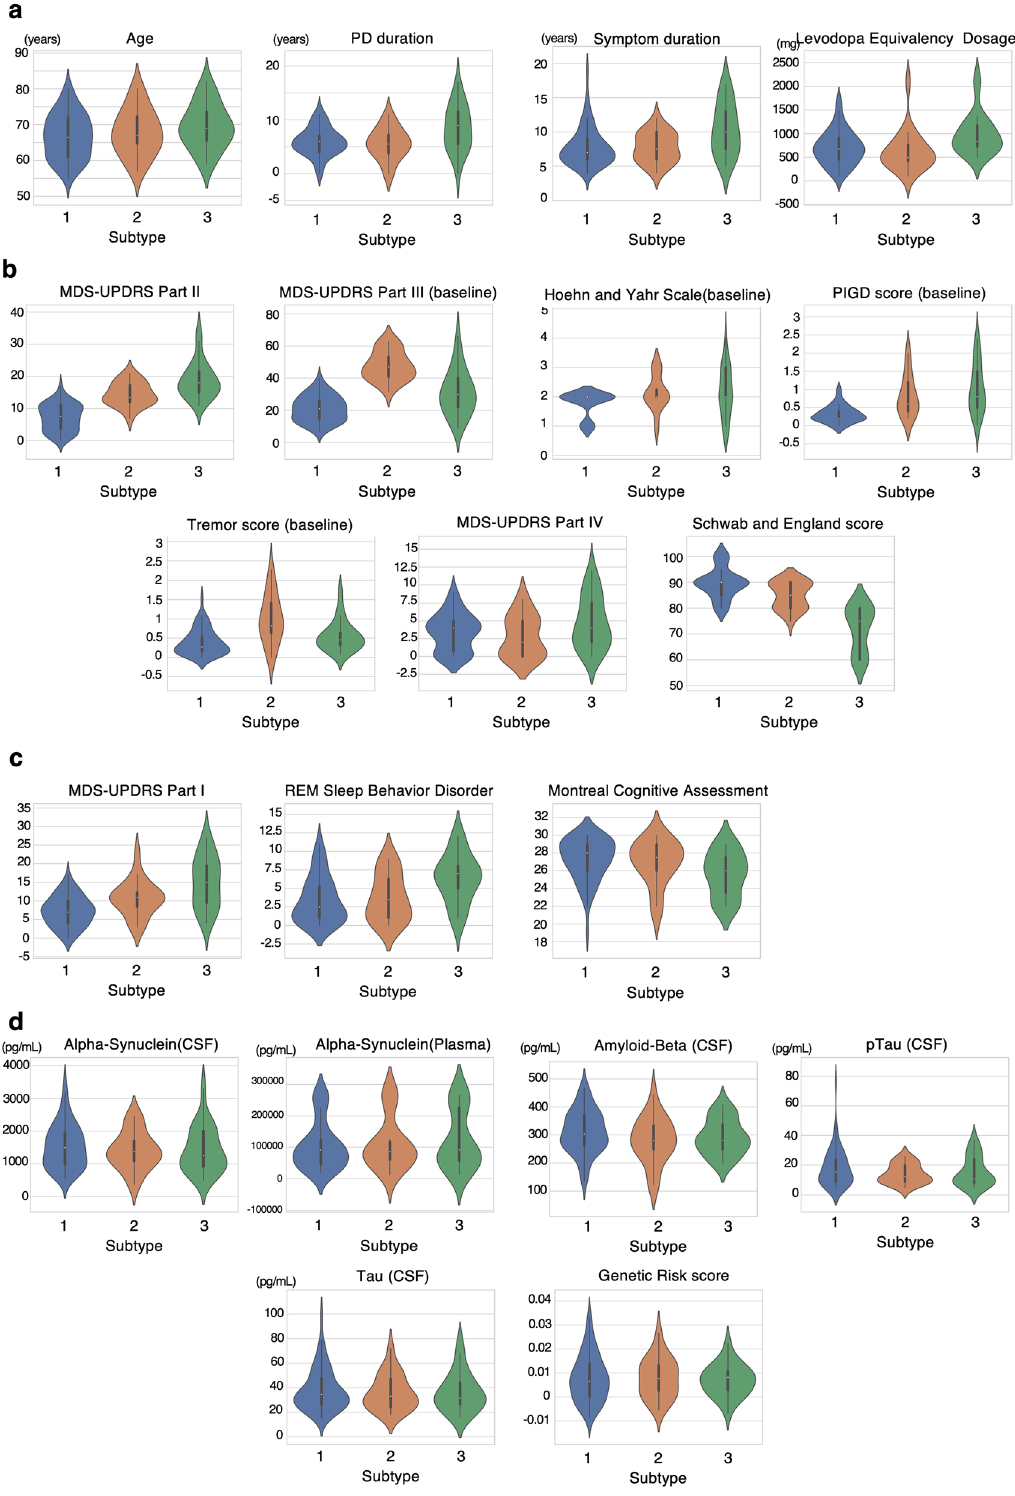
Fig. 1 Violin plots showing characteristics of the identi fi ed subtypes. Feature distributions of ( a ) demographics, ( b ) motor clinical assessments, ( c ) non-motor clinical assessments, and ( d ) biospecimen measurements/genetic risk score. The violin plots show a kernel density estimate of the feature distribution. The white dot within each plot represents the median, the edges of the box represent the interquartile and the line represents 1.5 times the interquartile